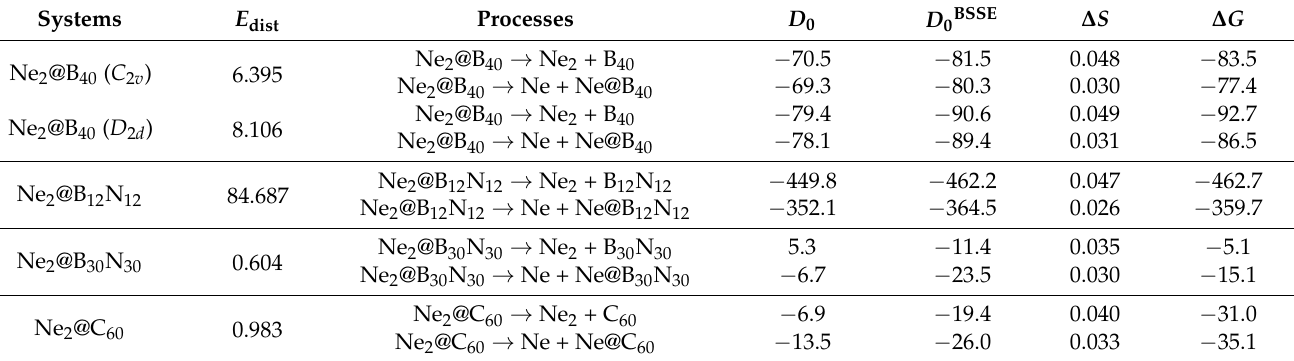
Table 1. Zero-point (ZPE) corrected dissociation energy ( D 0 ), both ZPE and BSSE corrected dissocia- tion energy ( D 0BSSE ), entropy change ( ∆ S ) and free energy change ( ∆ G ) for the dissociation processes, Ne 2 @cage → Ne 2 + cage, and Ne 2 @cage → Ne + Ne@cage along with the distortion energy ( E dist ) calculated as Equation (2). The energy values are provided in kcal mol − 1 and the entropy change in kcal mol − 1 K − 1